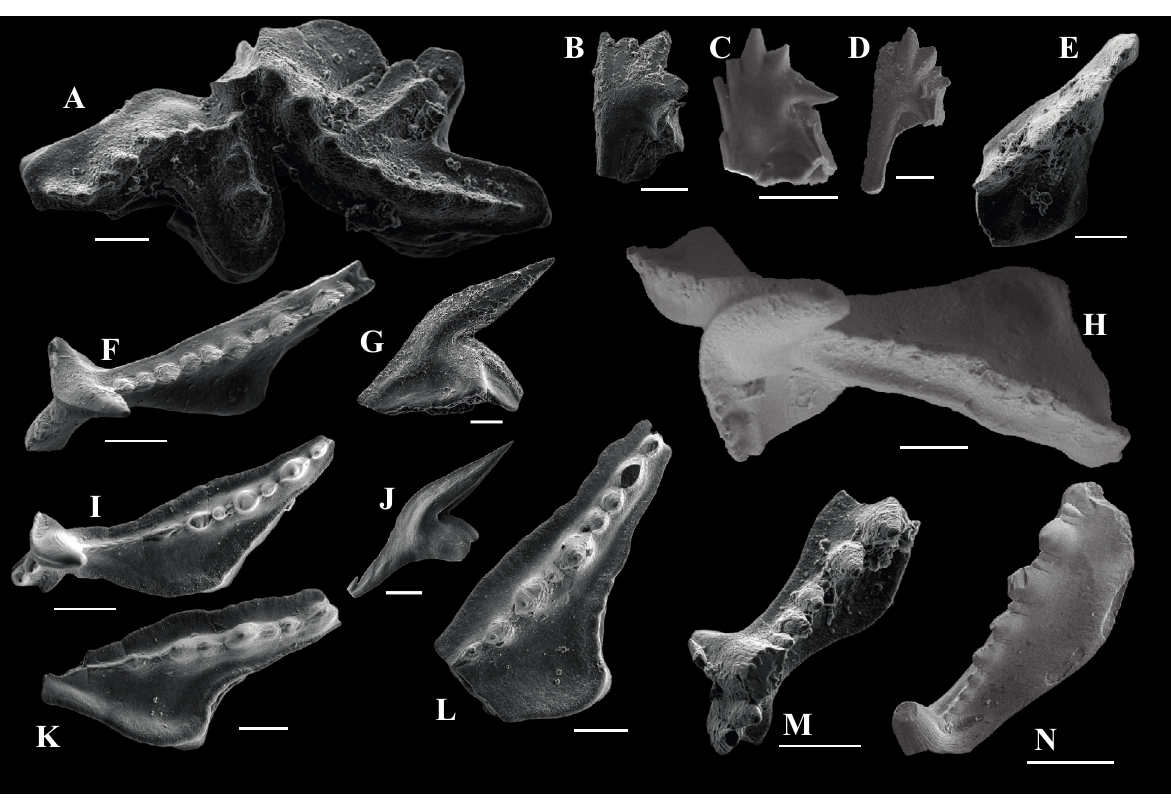
Fig. 5. Selected conodonts from the Peetri outcrop. Scale bar represents 100 μm. A – D , Amorphognathus tvaerensis Bergström: A, P element, sample Co6; B–D, M elements, samples Co6, Co14 and Co15. E – H , Baltoniodus variabilis Bergström: E, P Co9; F, G, P and M elements, sample Co12; H, P element, sample Co15. I – L , Baltoniodus alobatus Bergström: I, J, P 1 1 sample Co5; K, L, P elements, samples Co4 and Co2. M , N , Baltoniodus sp. Lindström: P 1